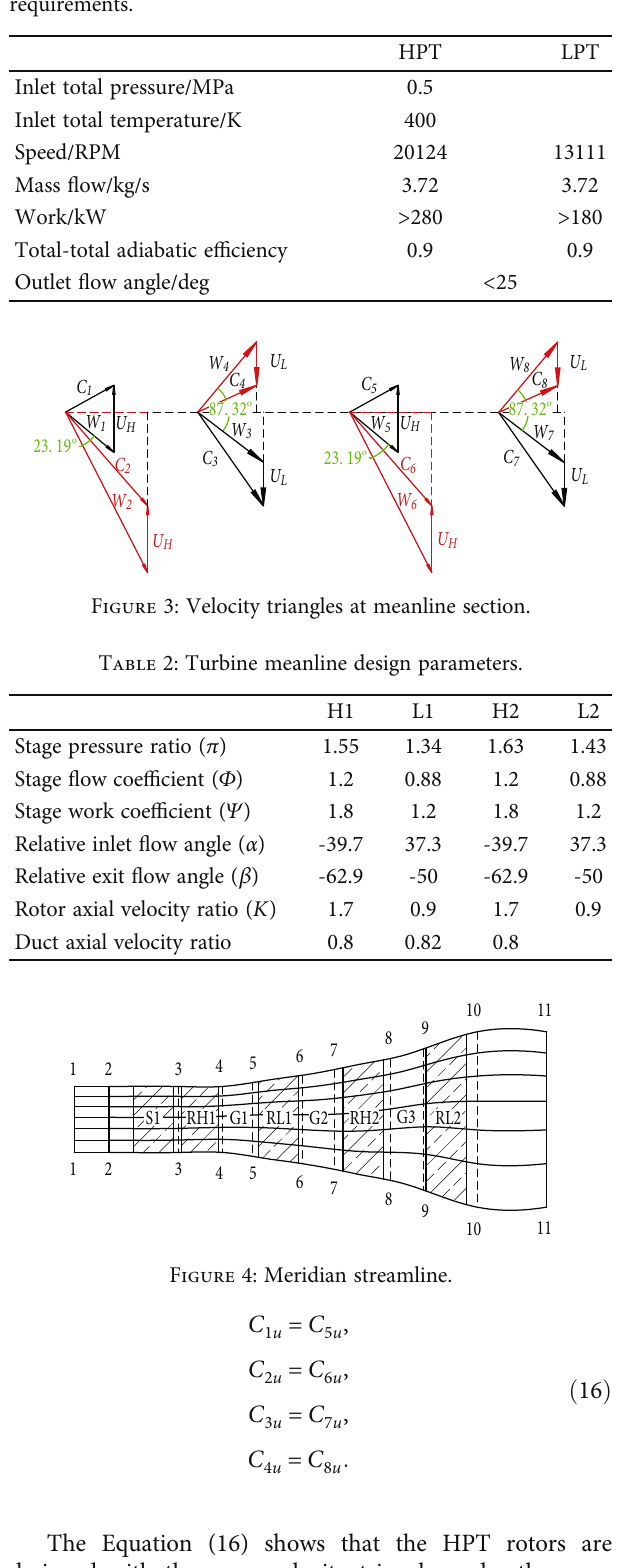
Table 1: Staggered counter-rotating model turbine performance